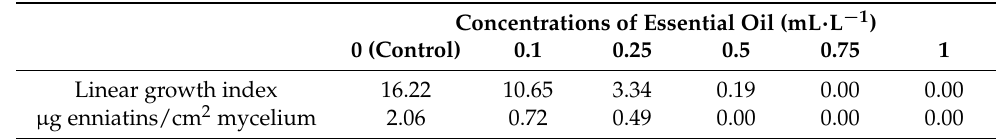
Table 4. Linear growth index of F. avenaceum and ENNs accumulation in presence of different concentrations of AP1 EO.